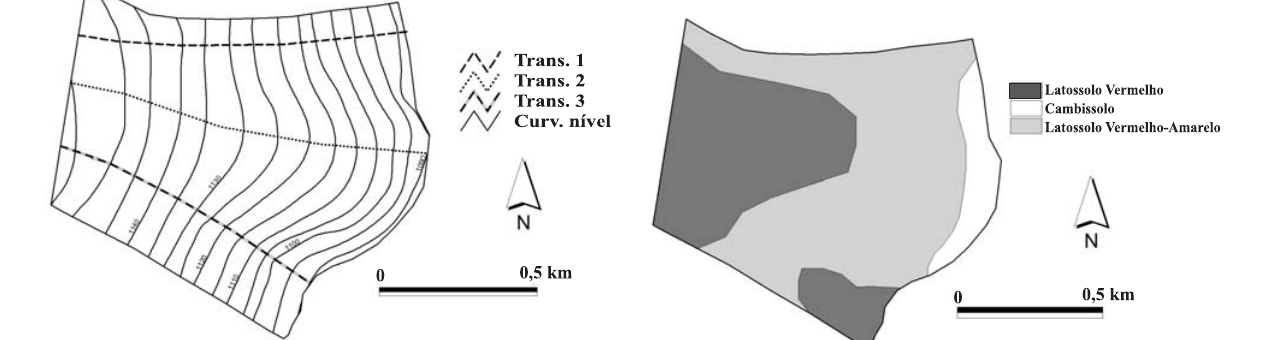
10).Figura 3. Mapa pedológico da gleba